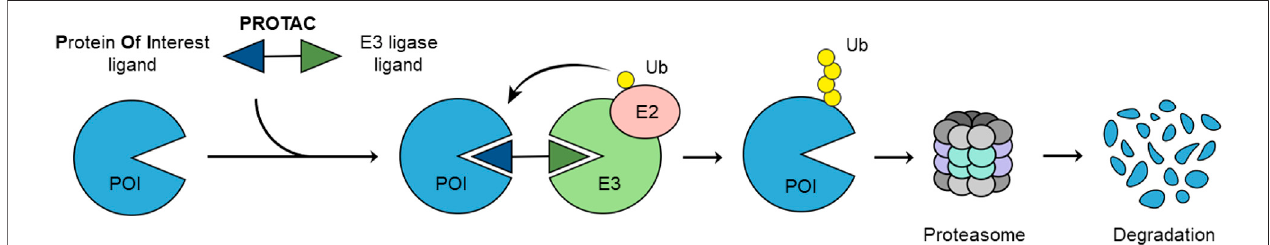
FIGURE 1 | PROTAC-induced degradation of target